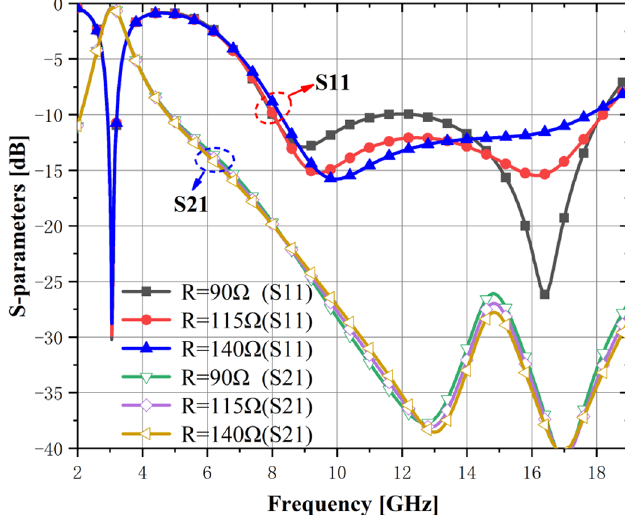
Fig. 5. S-parameter results of the designed FSR with different R.